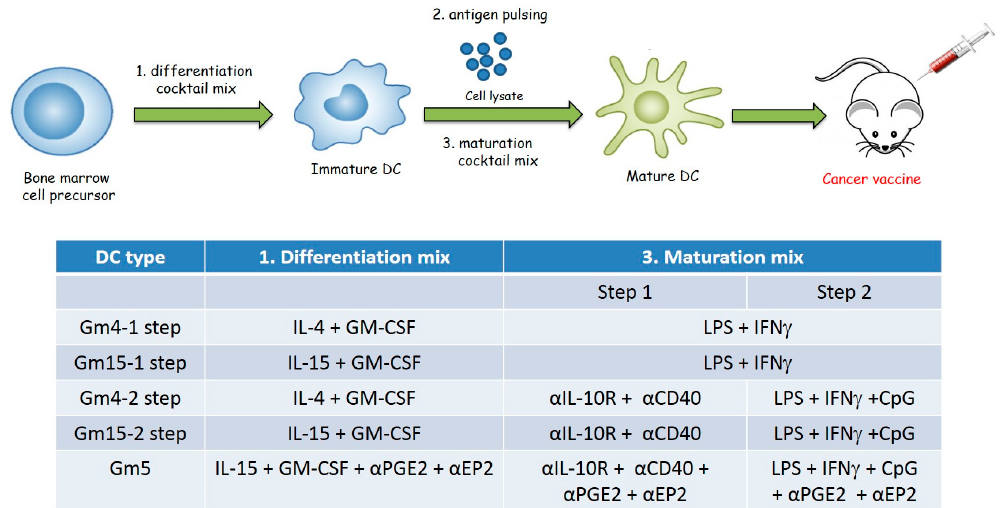
Figure 1. Schematic representation of the DC preparation protocol for animal vaccination. DC cell precursors were first isolated from the bone marrow of tumor-bearing mice and subsequently incubated with the stimuli indicated in the table for 4 days (1. differentiation mix). Immature DCs were then pulsed with squaric acid-treated ID8 cell lysate by overnight incubation. Finally, DCs were then matured by incubation with the stimuli indicated in the table (3. maturation mix). In particular, the maturation process was achieved either in one single step with 24 h incubation, or in two subsequent steps with incubation with the indicated reagents for 3 h (step 1), followed by overnight incubation with the indicated reagents (step 2). (DC: dendritic cells)